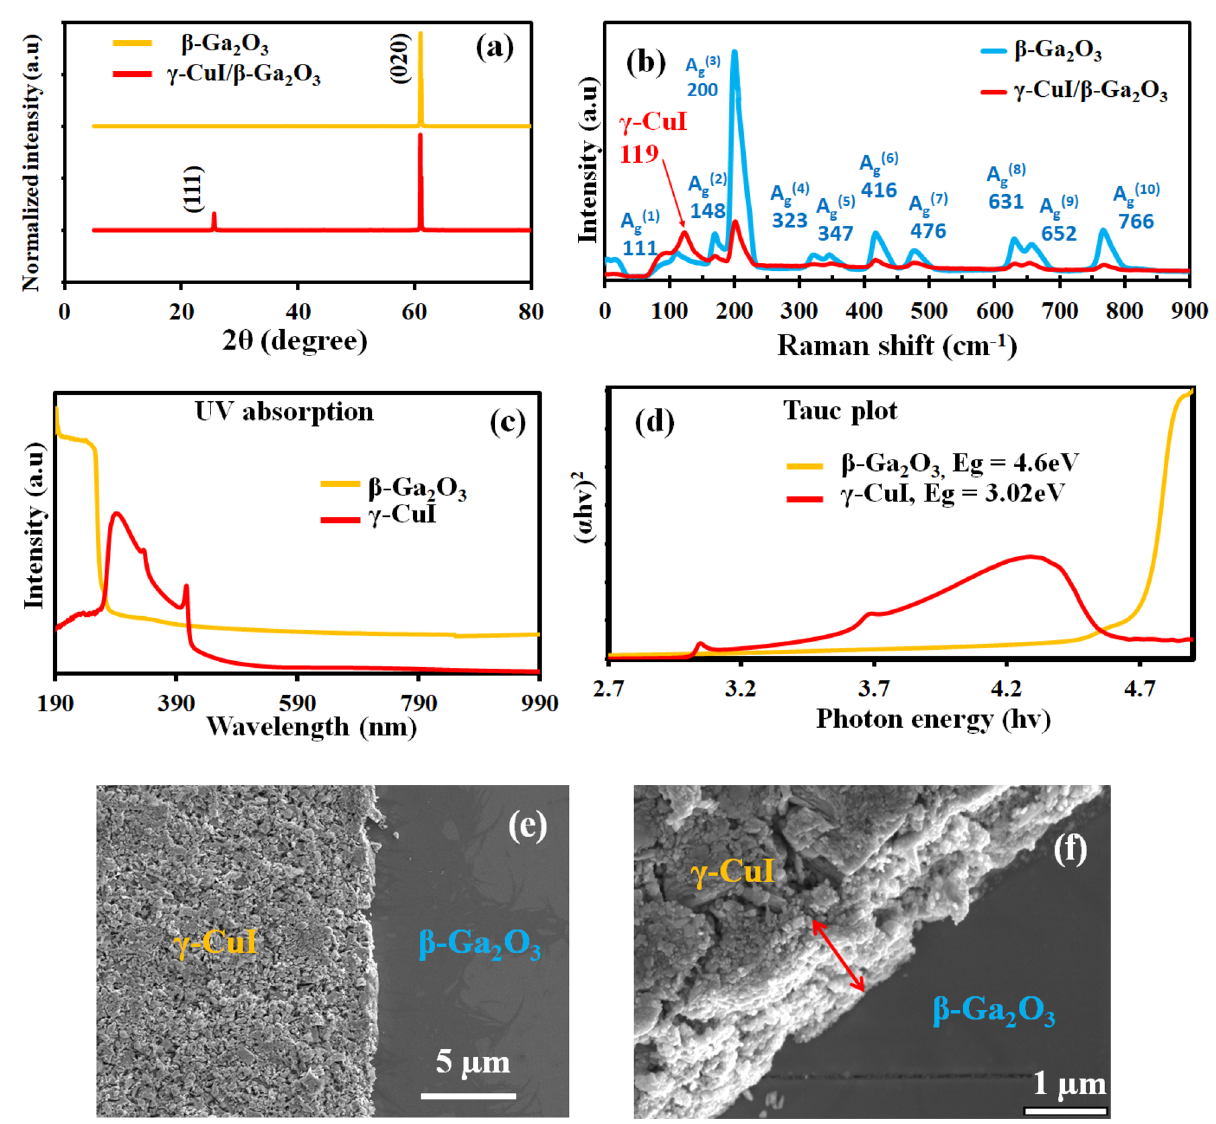
of the two materials; SEM image of the γ-CuI film, e on top of the O substrate and 2 3 β-Ga O O substrate and f a tilted view at the edge of the γ-CuI film 2 3 2 3 on β-Ga O substrate O 2 3 2